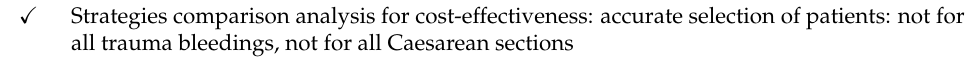
Table 3. Roadmap to improve the implementation of ICS in obstetrics and acute trauma bleeding. (cid:88) Strategies comparison analysis for cost-effectiveness: accurate selection of patients: not for all trauma bleedings, not for all Caesarean